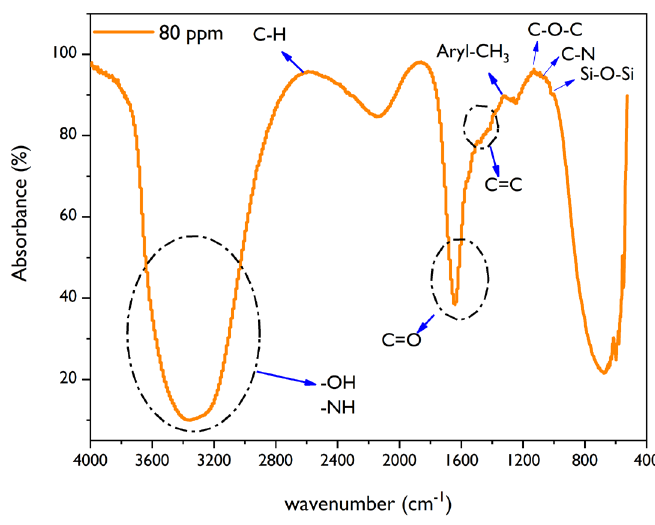
Figure 4. The FTIR results of liquid smoke inhibitor at 80 ppm.